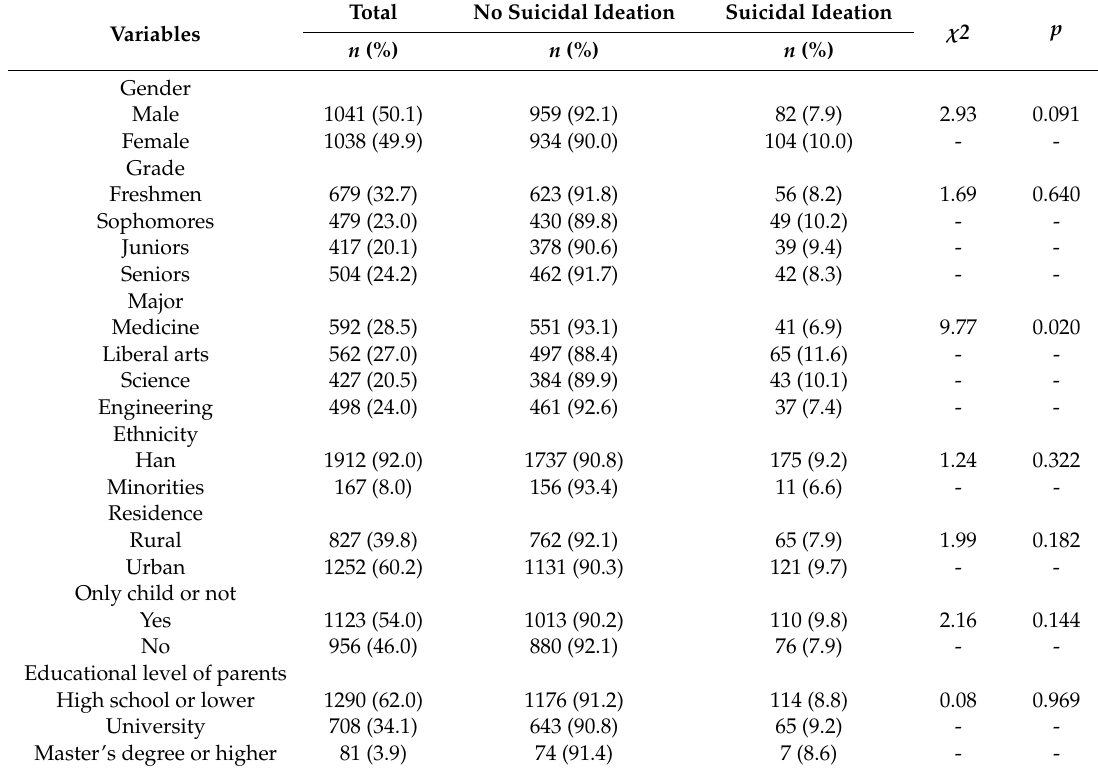
Table 1. Description and comparison of demographic characteristics between undergraduates with and without suicidal